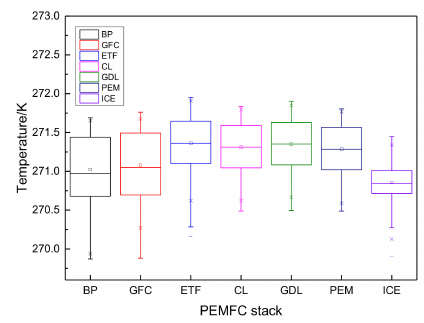
Figure 15. The temperature distribution in the vertical direction at 16th second.